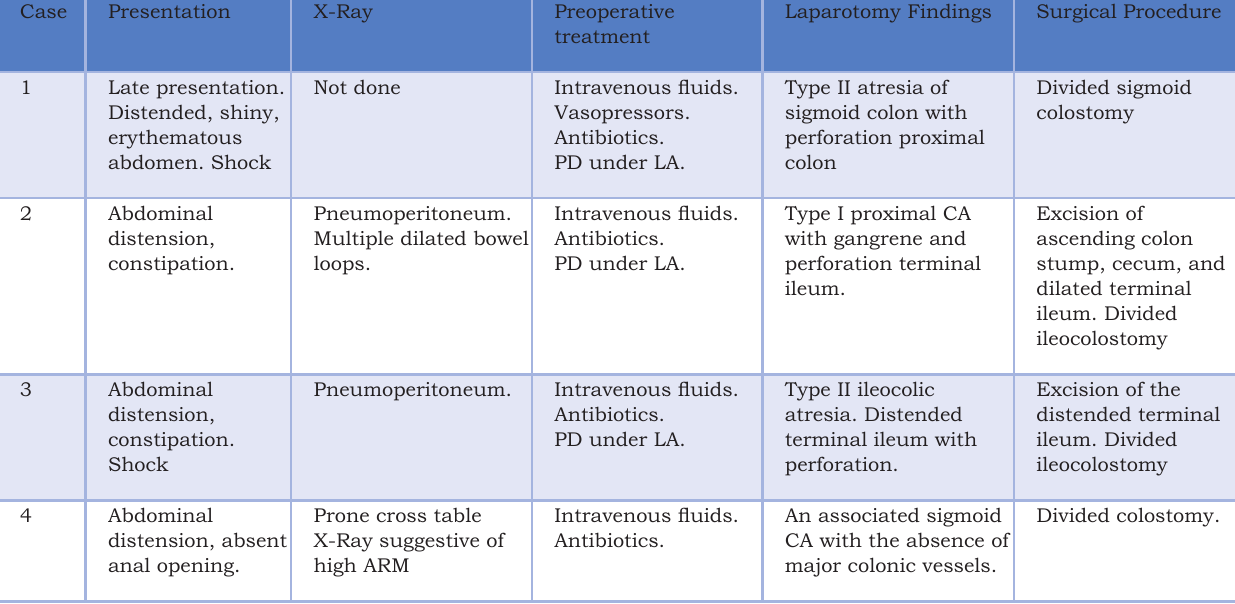
Table 1: Presentation and management of the 4 cases of CA operated without a contrast enema Case